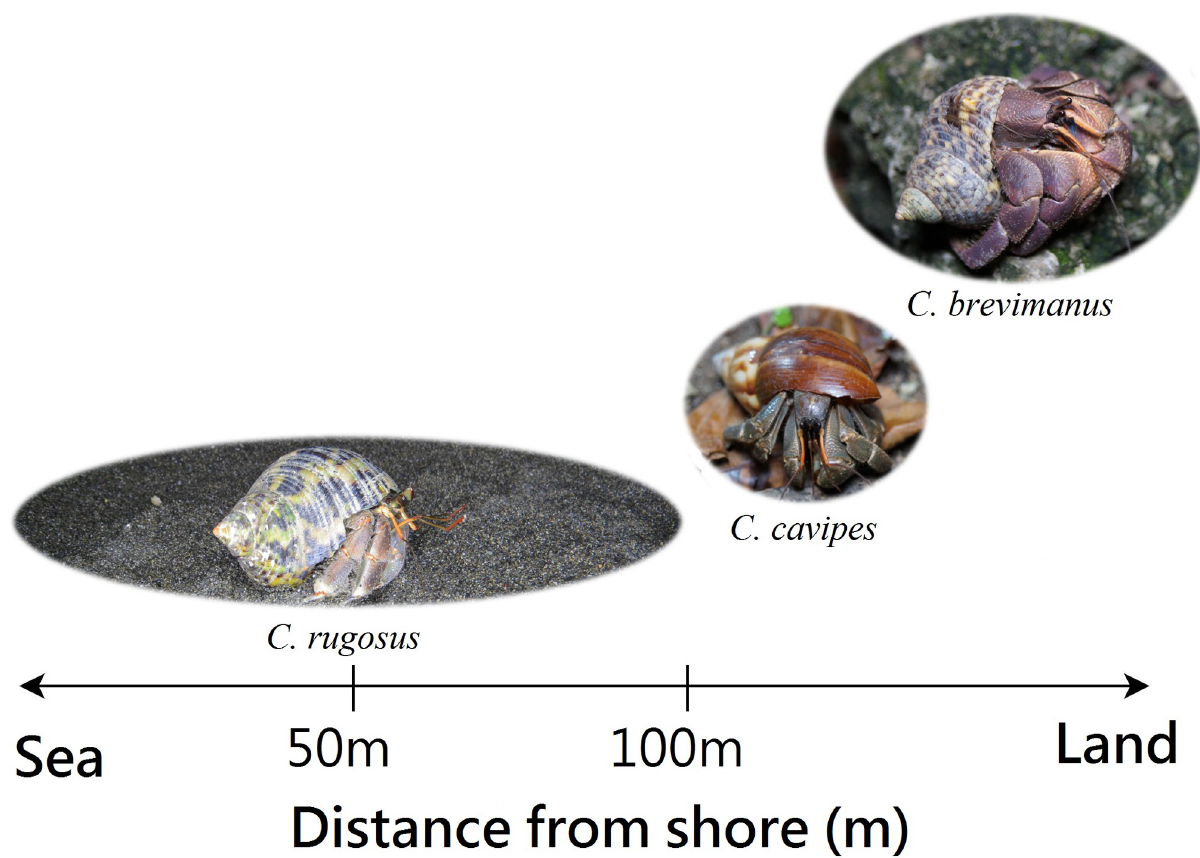
Fig 4. Distribution of three terrestrial hermit crab species in terms of distance from the shore. Widths of ovals indicated approximate ranges.